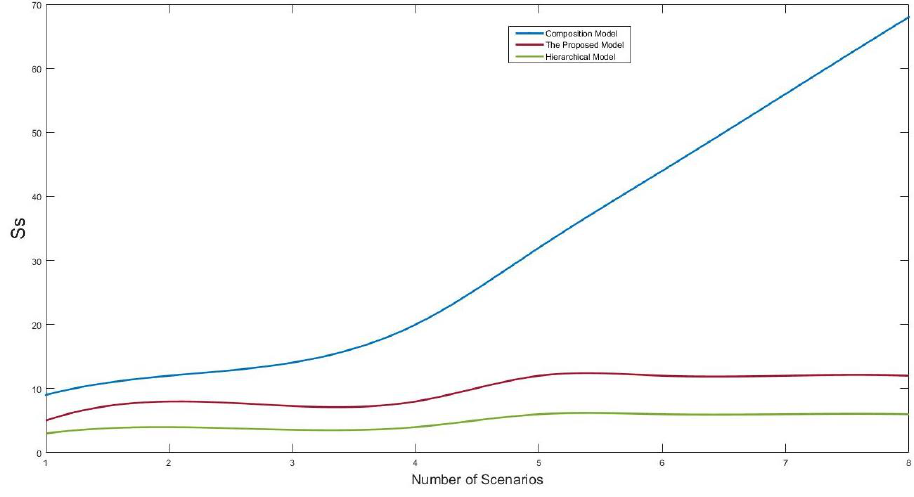
Figure 6. The Ss are generated by the proposed model and the comparison